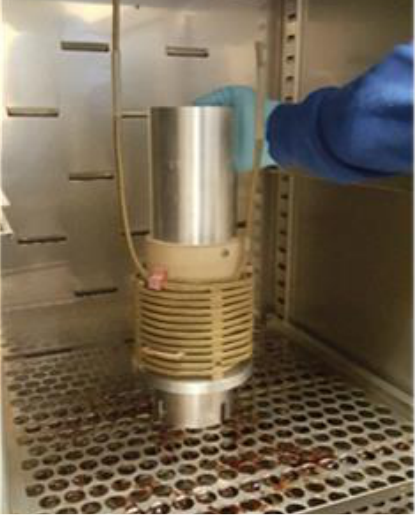
Figure 8. Core and winding assembly, in the vacuum drying oven.